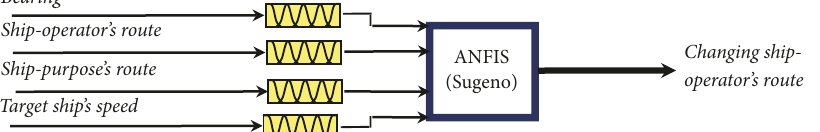
Figure 1: Neural-fuzzy ship collision prevention in a heavy traffic